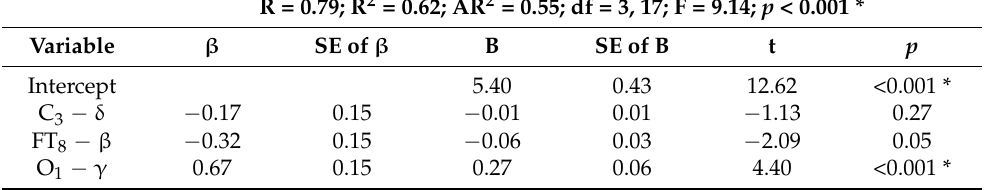
Table 6. Regression analysis for log-transformed high frequency heart rate variability and electroen- cephalography variables in train